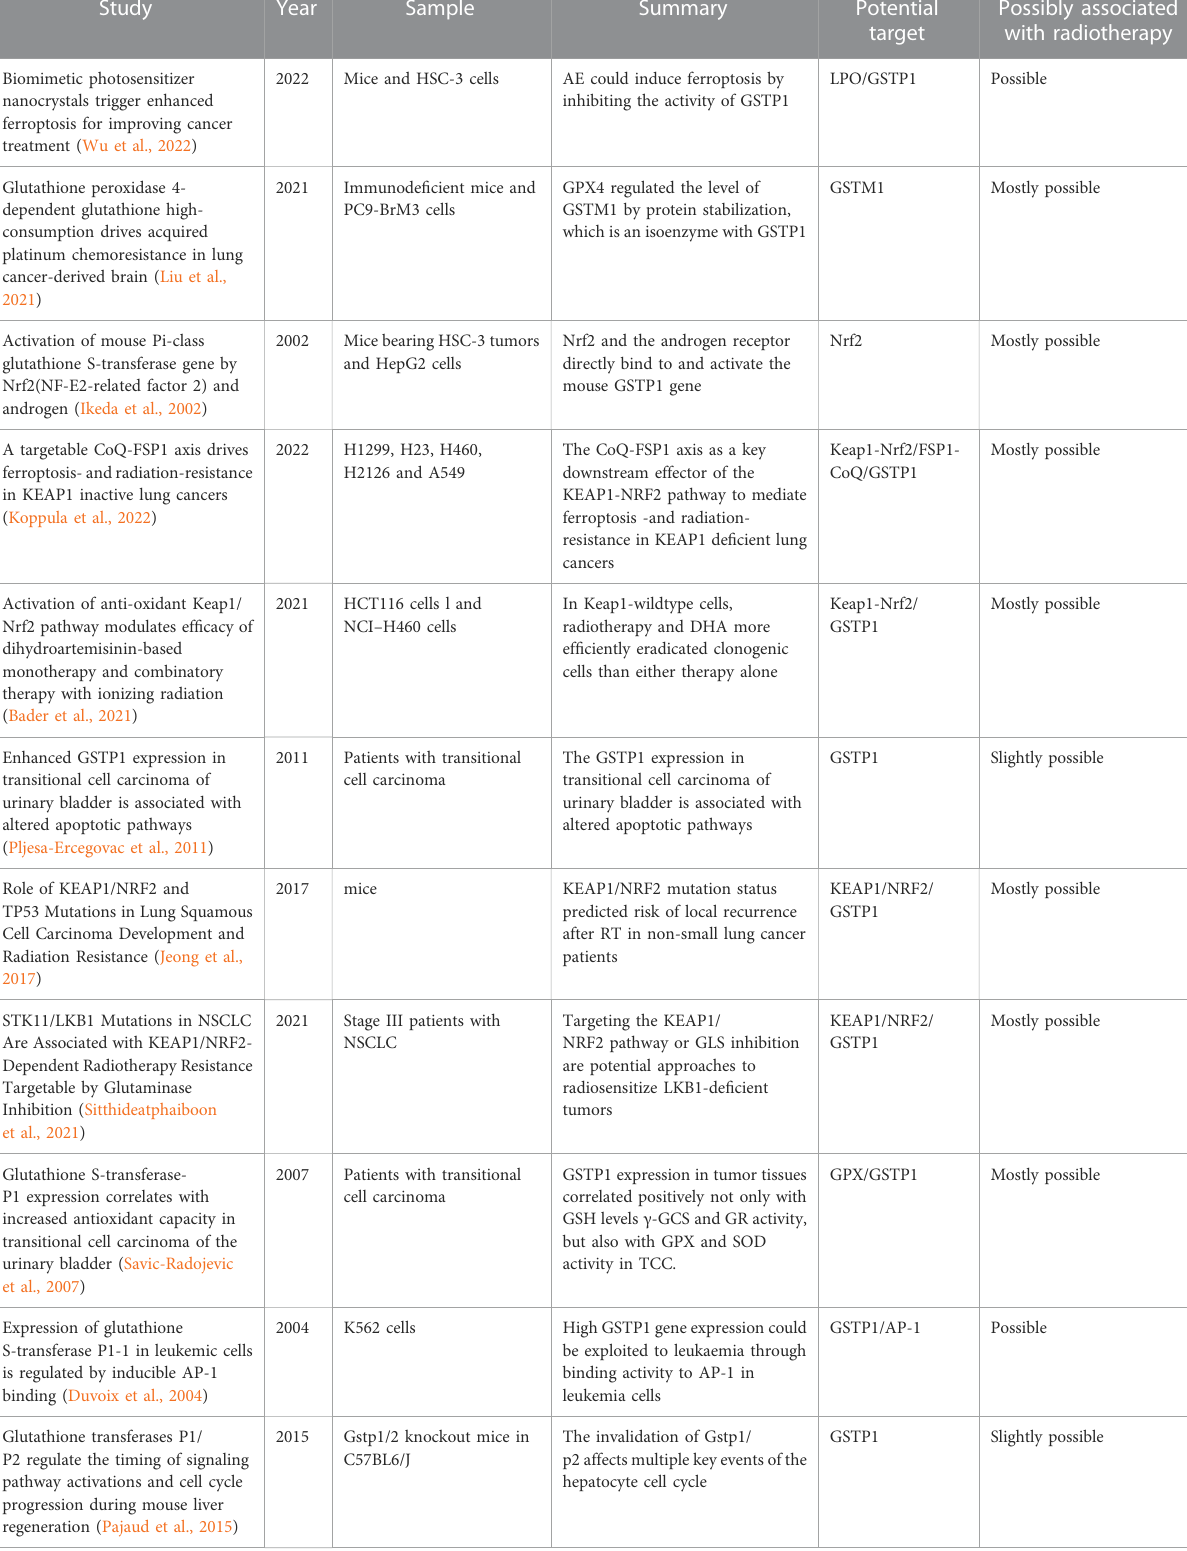
TABLE 1 The potential role of GSTP1 in ferroptosis pathway for tumor